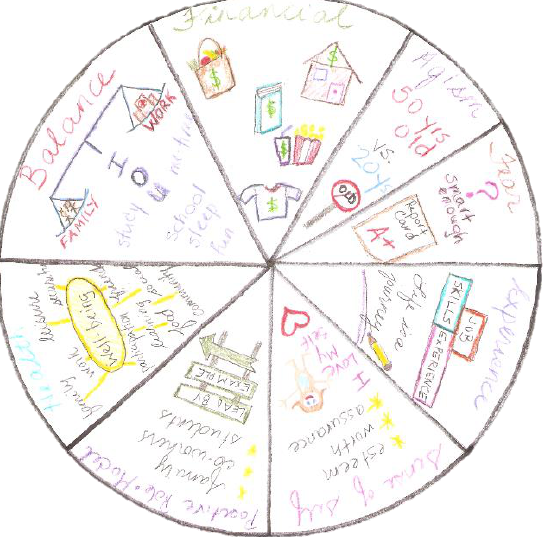
Figure 3. Example of a student mandala drawing